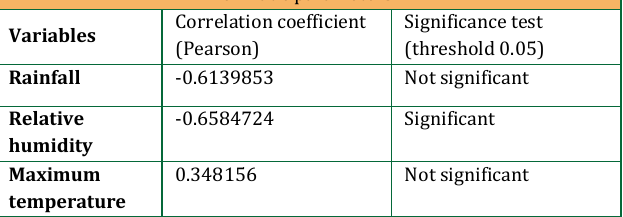
Table 2: Correlation analysis between number of active fires and